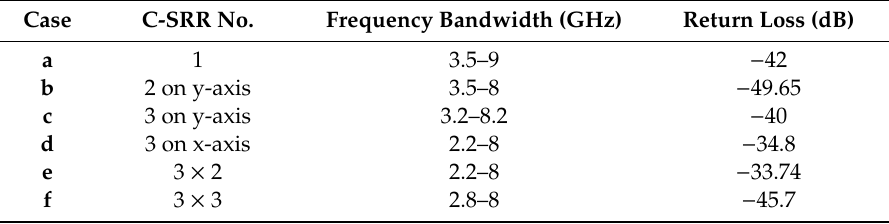
Figure 20. Different number of C-SRR on the back of the antenna. Arrays of ( a ) 1 × 1 ( b ) 1 × 2 ( c ) 1 × 3 ( d ) 3 × 1 ( e ) 3 × 2 ( f ) 3 × 3. Table 4. Results of C-SRR implementations with the